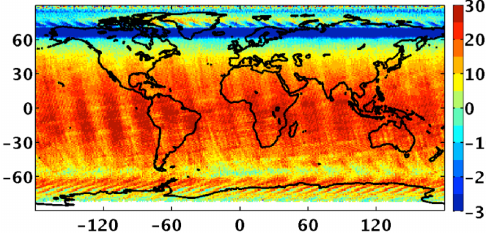
Figure 3. Monthly mean insolation difference (Wm − 2 ) between NPP CERES and Aqua CERES (NPP–Aqua) for April